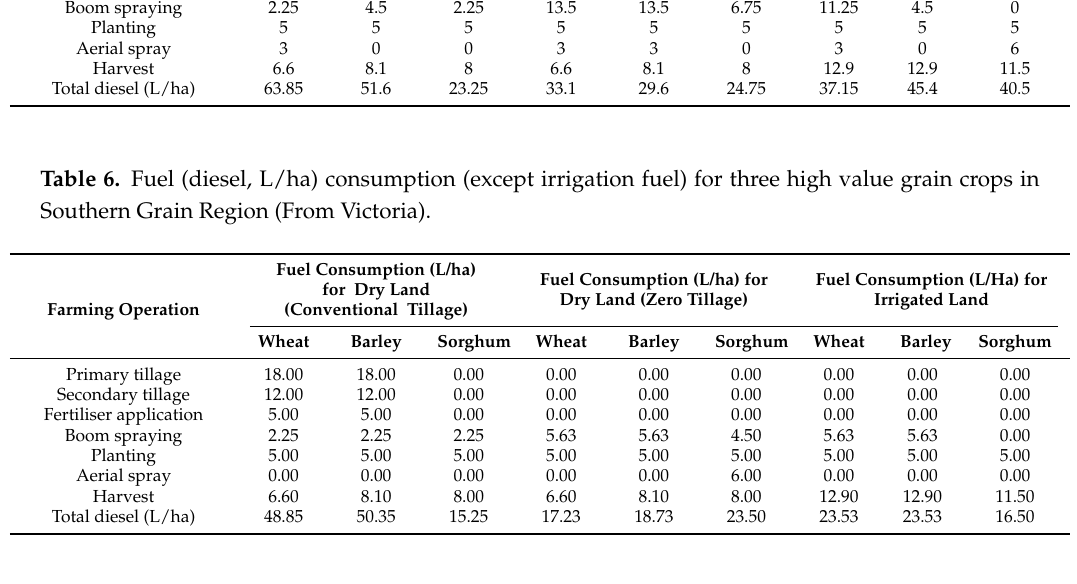
Table 7. Fuel (diesel, L/ha) consumption (except irrigation fuel) for three high value grain crops in Western Grain